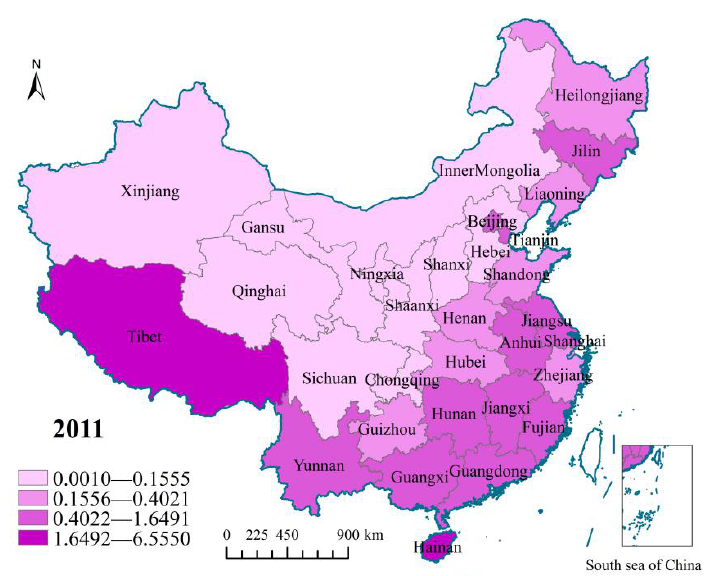
Figure 2. Distribution of forestry ecological efficiency (FEE) in China in 2011.